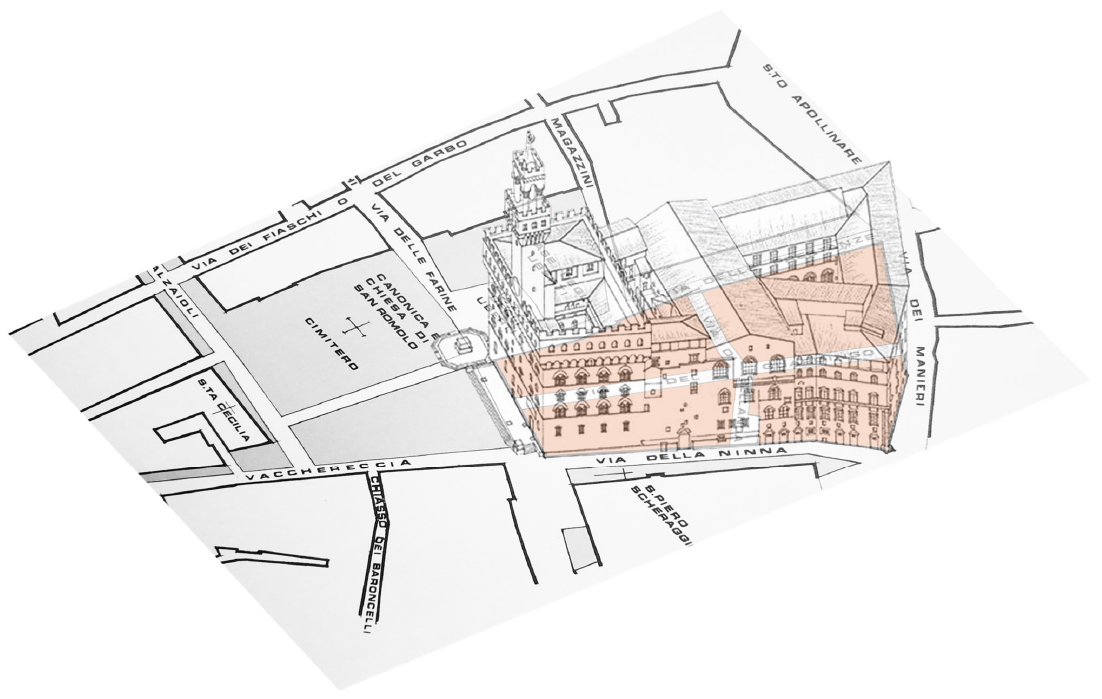
Figure 5. Reconstruction of the urban layout of the city during the Medieval period (adapted from Lensi